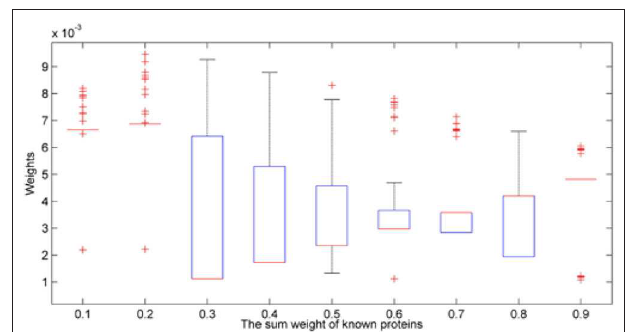
FIGURE 4 | Box diagrams of result with different initial